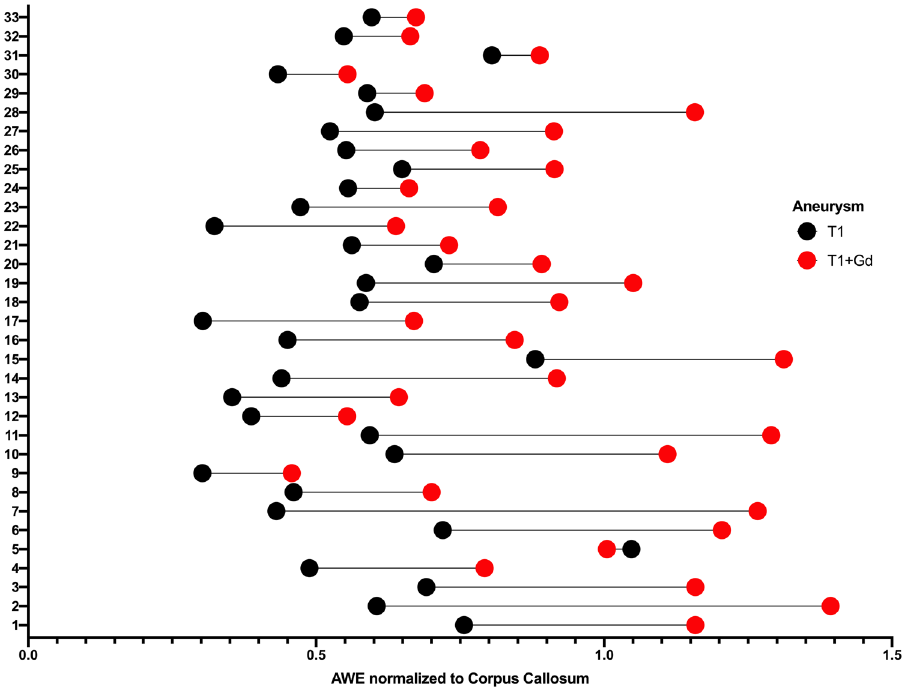
Figure 4. Whisker plot representation of each aneurysm demonstrating the change in AWE normalized to the CC between the pre (black) and the post-Gd (red) T1 sequences. T1 AWE normalized to CC µ = 0.56 ± 0.16. T1 + Gd AWE normalized to CC µ = 0.89 ± 0.25. There is a wide range of Gd uptake suggesting that aneurysms walls are very heterogeneous. AWE aneurysmal wall